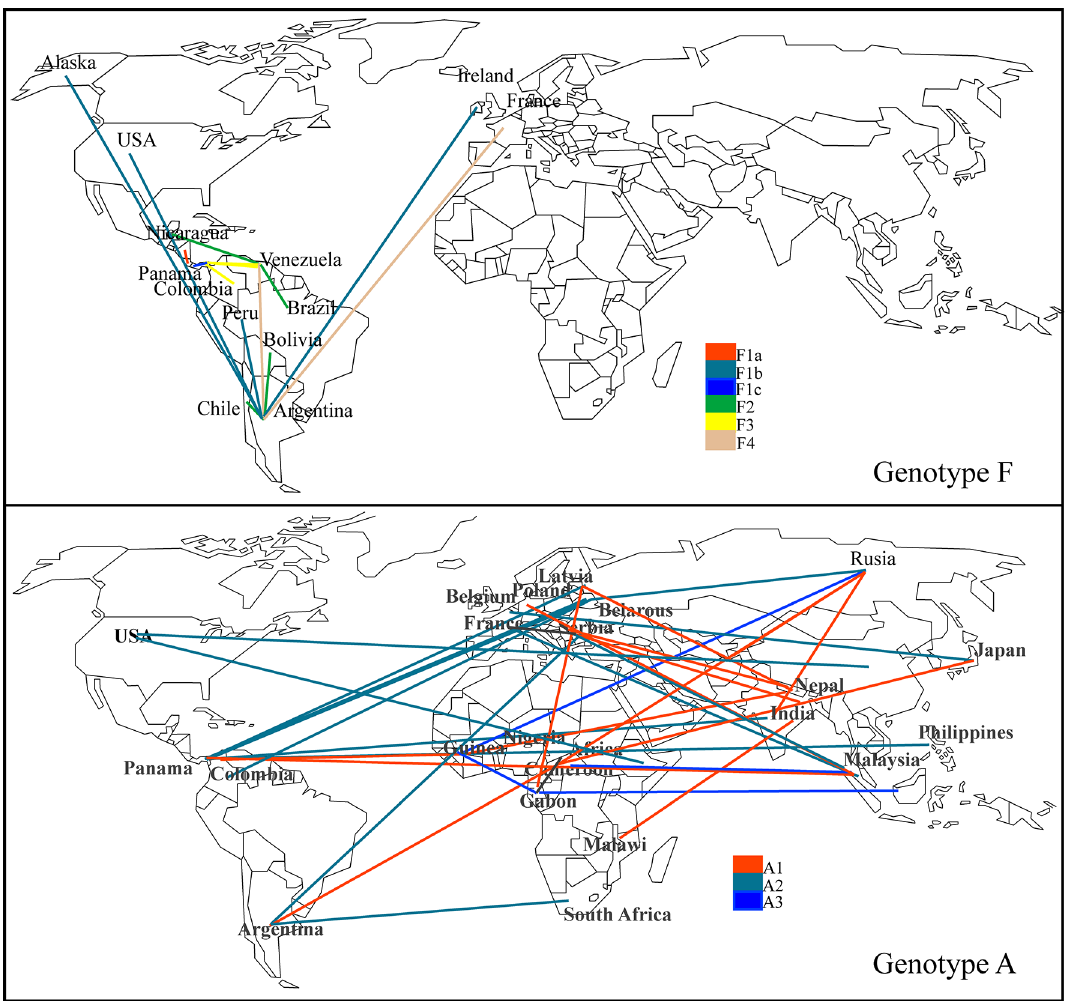
Fig 4. Spatial dissemination of HBV genotypes across the world. Lines between countries represent sequences in which transition location occurs, and were supported by a significant non-zero rate (Bayes Factor > 3). Map (a) is for genotype F (a), and map (b) for genotype A. Lines were colored according to the sub-genotype involved in the